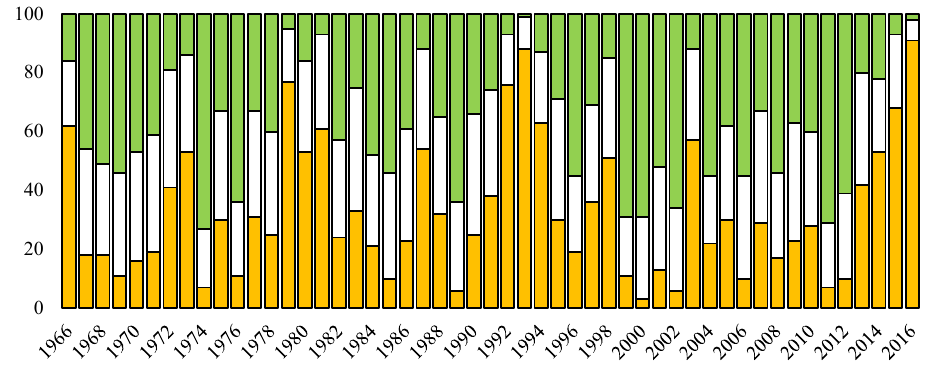
Figure 10. Categorical probabilities for JFM precipitation totals ( y axis) in each year, as predicted by the regional-scale